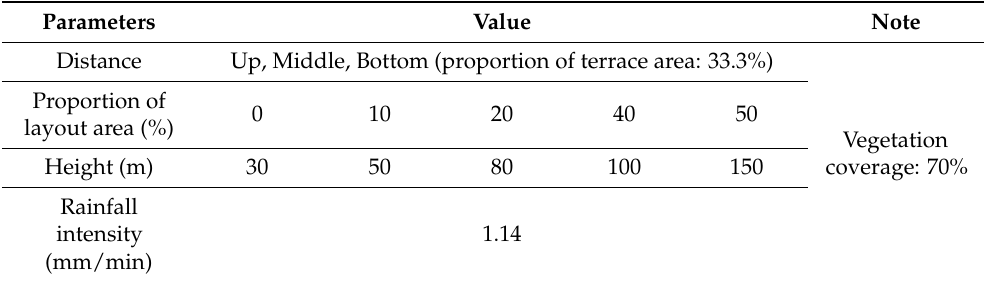
Table 1. Working condition design of spatial distribution of terraces. Parameters